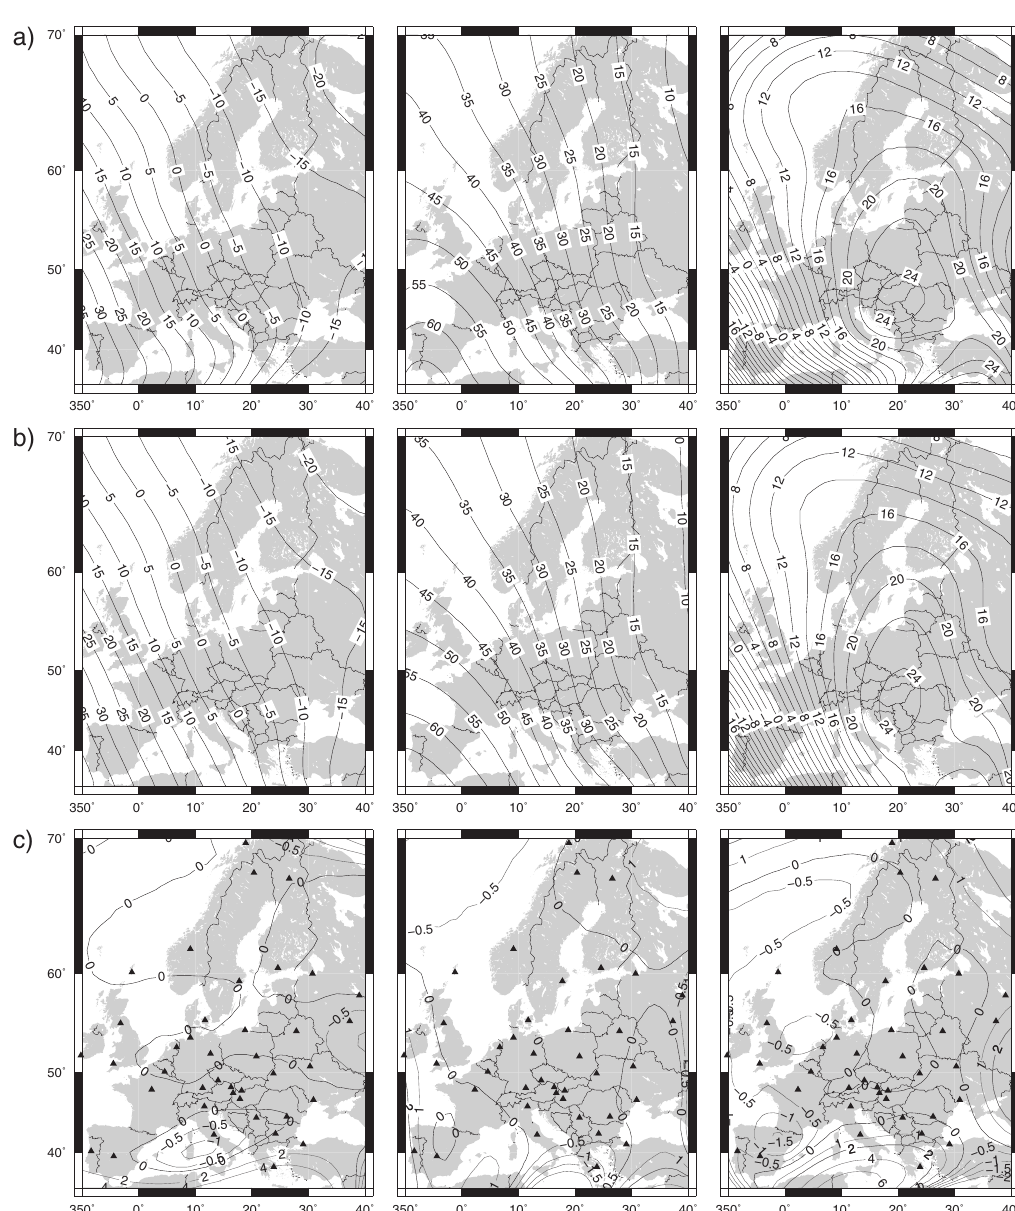
Fig. 3a-c. Maps of the X (left), Y (center) and Z (right) secular variation components at epoch 1980.5 obtained from: (top) SCHA at 43 observatory locations (model EU_OBS) (middle) SCHA at 43 observatory locations complemented with eleven synthetic observatories (model EU_MIX). Maps of differences between EU_MIX and EU_OBS, (EU_MIX- EU_OBS), model values are also shown (bottom). Triangles show the observatory lo- cations. Units nTyr –1 . Mercator map